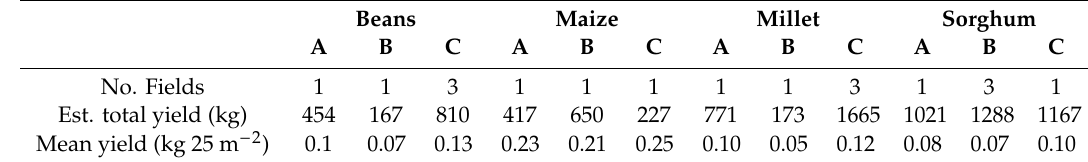
Table 3. Household-specific yield quantification for three exemplary households (A, B, and C). Beans Maize Millet Sorghum A B C A B C A B C A B C 1 1 3 1 1 1 1 1 3 1 3 1 Est. total yield (kg) 454 167 810 417 650 227 771 173 1665 1021 1288 1167 Mean yield (kg 25 m − 2